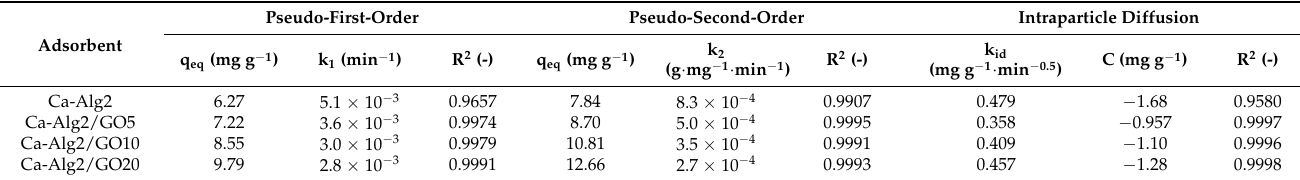
Table 4. Kinetic parameters for MB adsorption onto Ca-Alg2, Ca-Alg2/GO5, Ca-Alg2/GO10 and Ca-Alg2/GO20 dried beads. Adsorbent